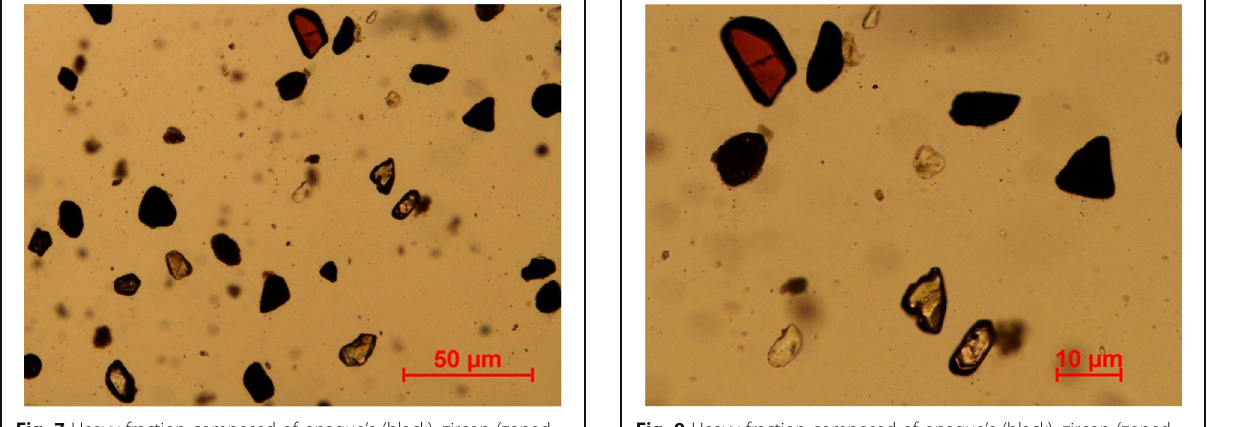
Fig. 7 Heavy fraction composed of opaque ’ s (black), zircon (zoned colorless euhedral to subhedral grains), and staurolite (reddish brown at the upper part of photo), heavy fraction, PPL. × 40